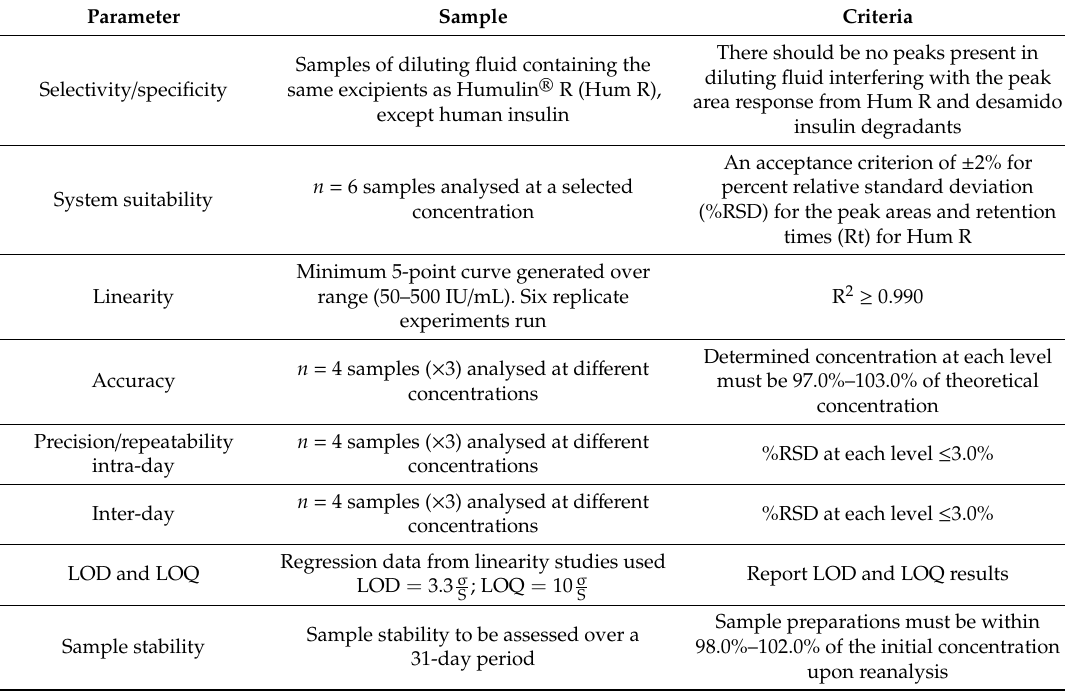
Table 1. Validation